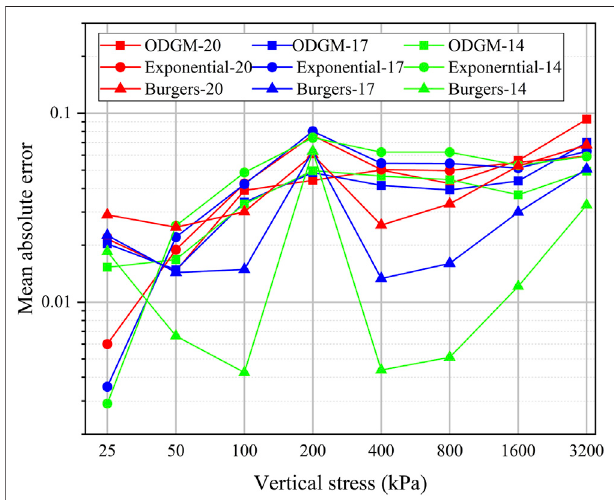
FIGURE 12 | Exponential fi tting parameters under different vertical stresses (20 data points/17 data points/14 data points)). (A) is exponential, (B) is Burgers.